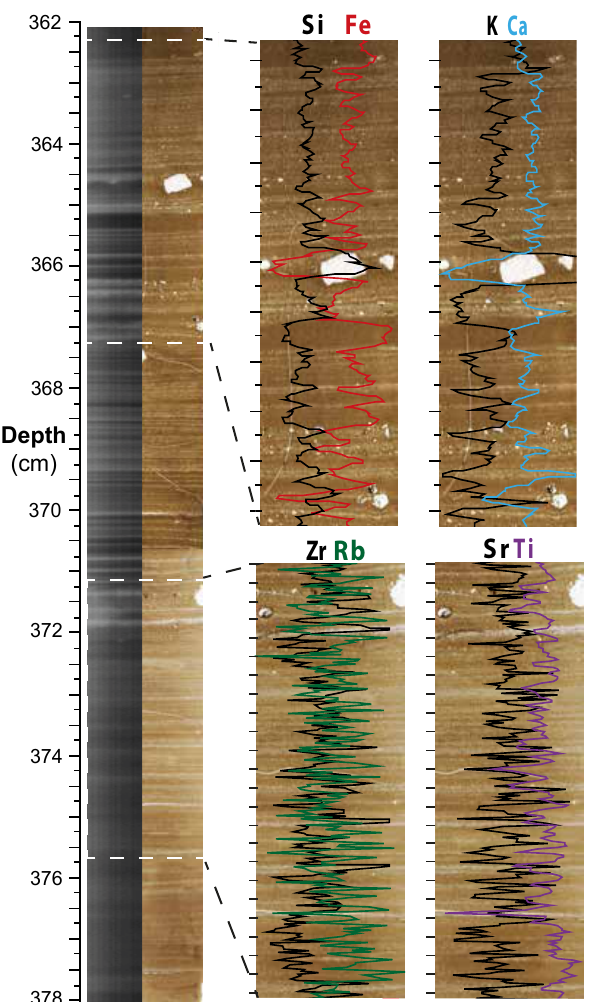
Figure 4. High-resolution element composition of a varved sedi- Fig. 4. High-resolution element composition of a varved sediment section of core PS1795 2 ment section of core PS1795 (362–378cm). Left: X-radiographs, (362 – 378 cm). Left side shows X-radiographs, generated using X-ray fluorescence (XRF) 3 generated using X-ray fluorescence (XRF) scanner and scanned im- ages of the thin sections. Right: close-up images of thin sections scanner and scanned images of the thin sections. Right side are zoomed images of thin 4 plus XRF scanner element counts every 0.2mm of the sediment sections plus XRF-scanner element counts every 0.2 mm of the sediment slabs, from which 5 slabs, from which the thin sections were produced. the thin sections were produced. 6